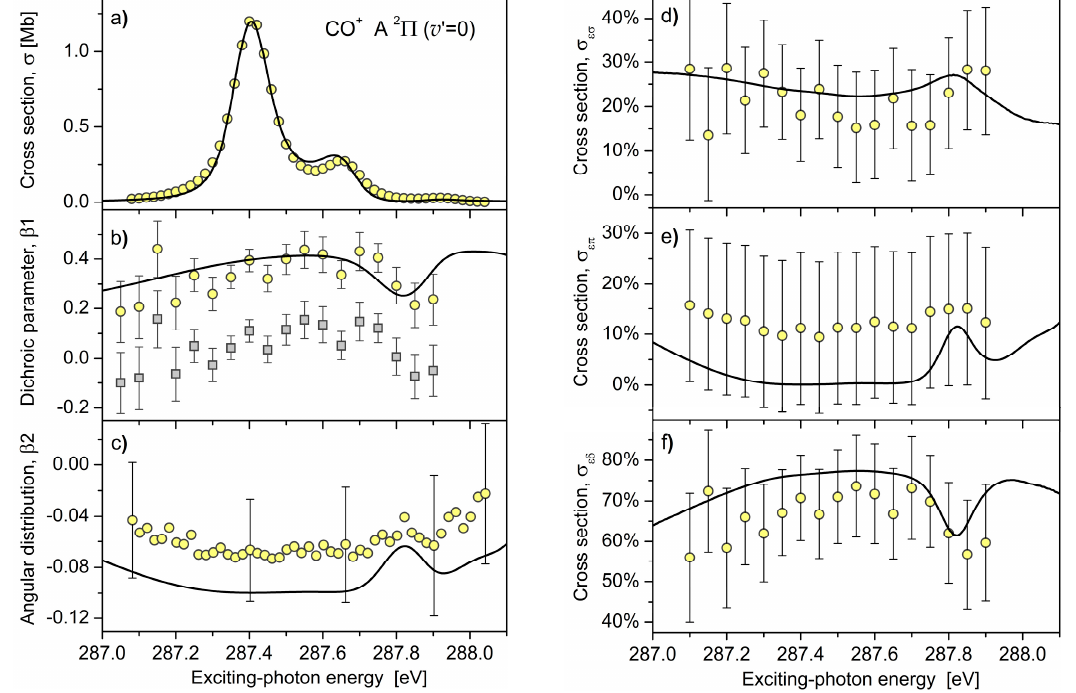
Figure 1. Comparison between the theory (solid curves) and experiment (open circles). Panel ( a ): cross section for the population of the CO + A 2 Π ( v ′ = 0) vibronic state in the vicinity of the C*O (1s → π *) resonance (data from Reference [14]). Panels ( b , c ): dichroic parameter β 1 (present calculations and measurements) and angular distribution parameter β 2 (data from Reference [14]) for the A 2 Π ( v ′ = 0) → X 2 Σ + ( v ″ = 0) fluorescence band of the CO + ion emitted after Auger decay of the C*O (1s → π *) resonance. The open squares in panel b) illustrate uncorrected data, while β 1 values shown by open circles account for different transmissions of the circularly polarized fluorescence (see Section 3.3 for details). Panels ( d – f ): Relative partial photoionization cross sections (in percent from the total cross section shown in panel ( a )) for the emission of three partial electron waves ε σ , ε π , and ε δ , resulting in the population of the CO + A 2 Π ( v ′ = 0) vibronic state (obtained via Equation (3) by combining the present data for β 1 and data from Reference [14] for β 2).